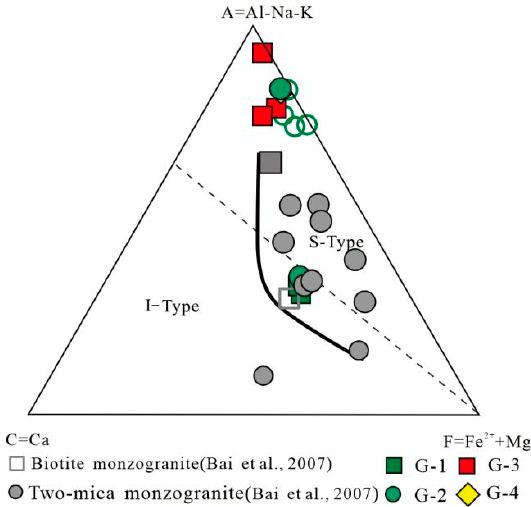
Figure 14. ACF diagrams of granitoids from Chuankou ore field.